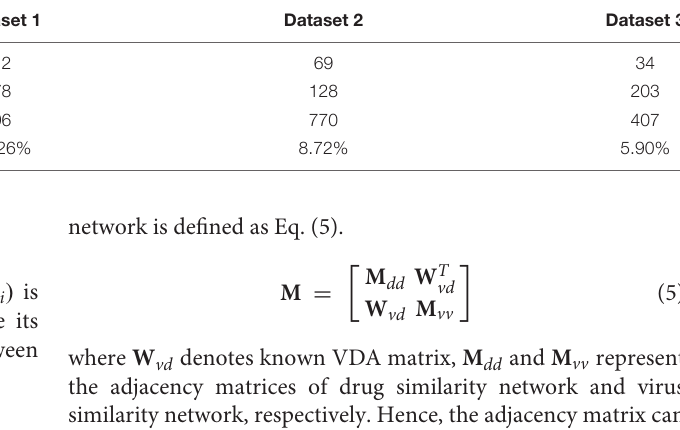
TABLE 1 | Details of three VDA datasets.